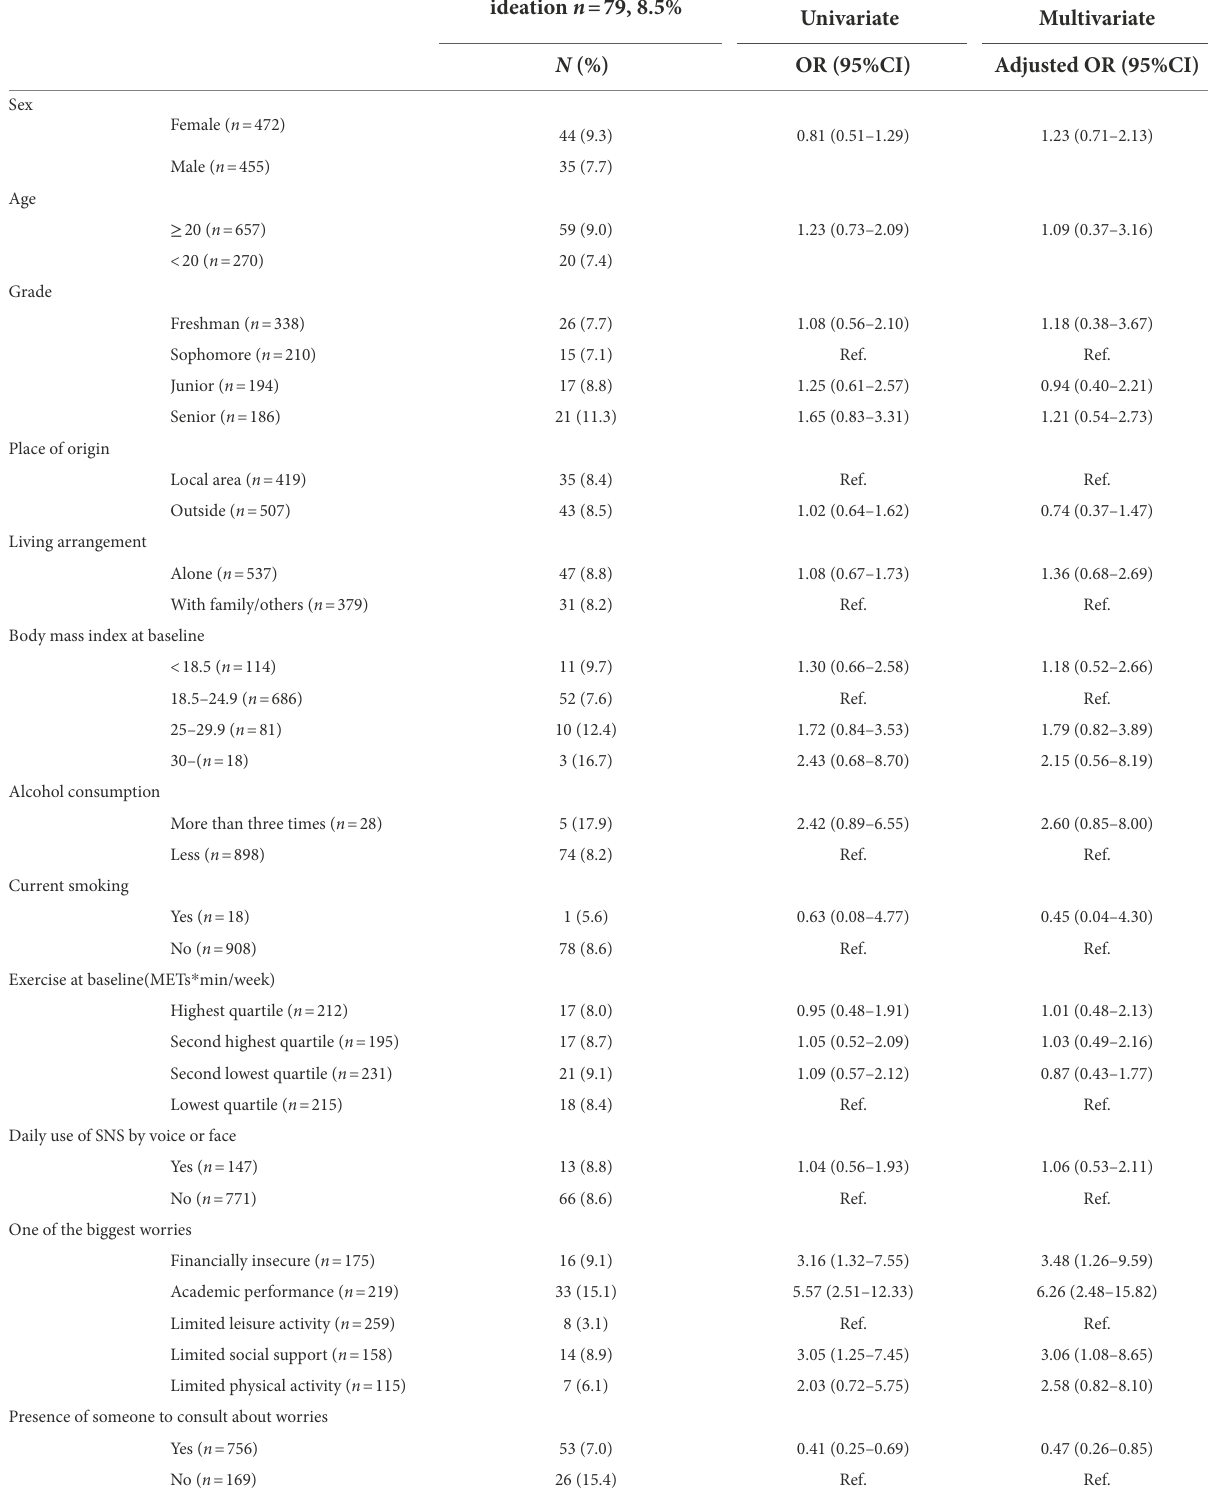
TABLE 4 Risk and coping factors associated with new onset of suicide related ideation at T 2 (in March–May 2021): n = 928. New onset of suicide related ideation n = 79,